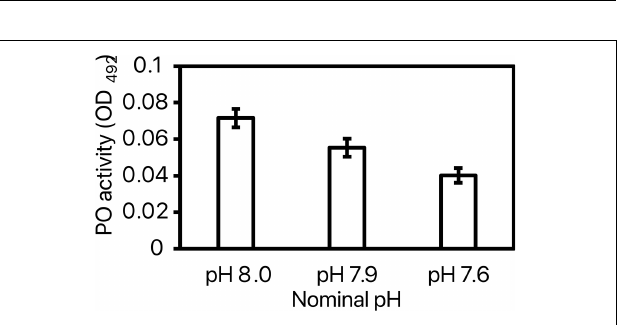
FIGURE 5 | Superoxide production (SOP) measured at OD 630 of the 3 tested nominal pH NIST .